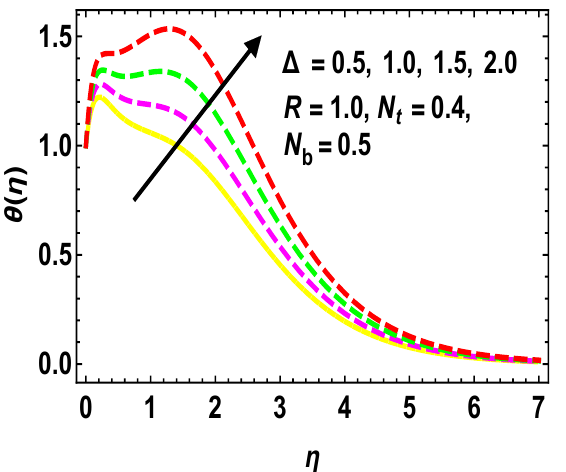
Figure 9. Outcomes of θ ( η ) for ∆ > 0 where yellow, magenta, green, and red lines represent for ∆ = 0.5, ∆ = 1.0, ∆ = 1.5, and ∆ = 2.0 respectively.